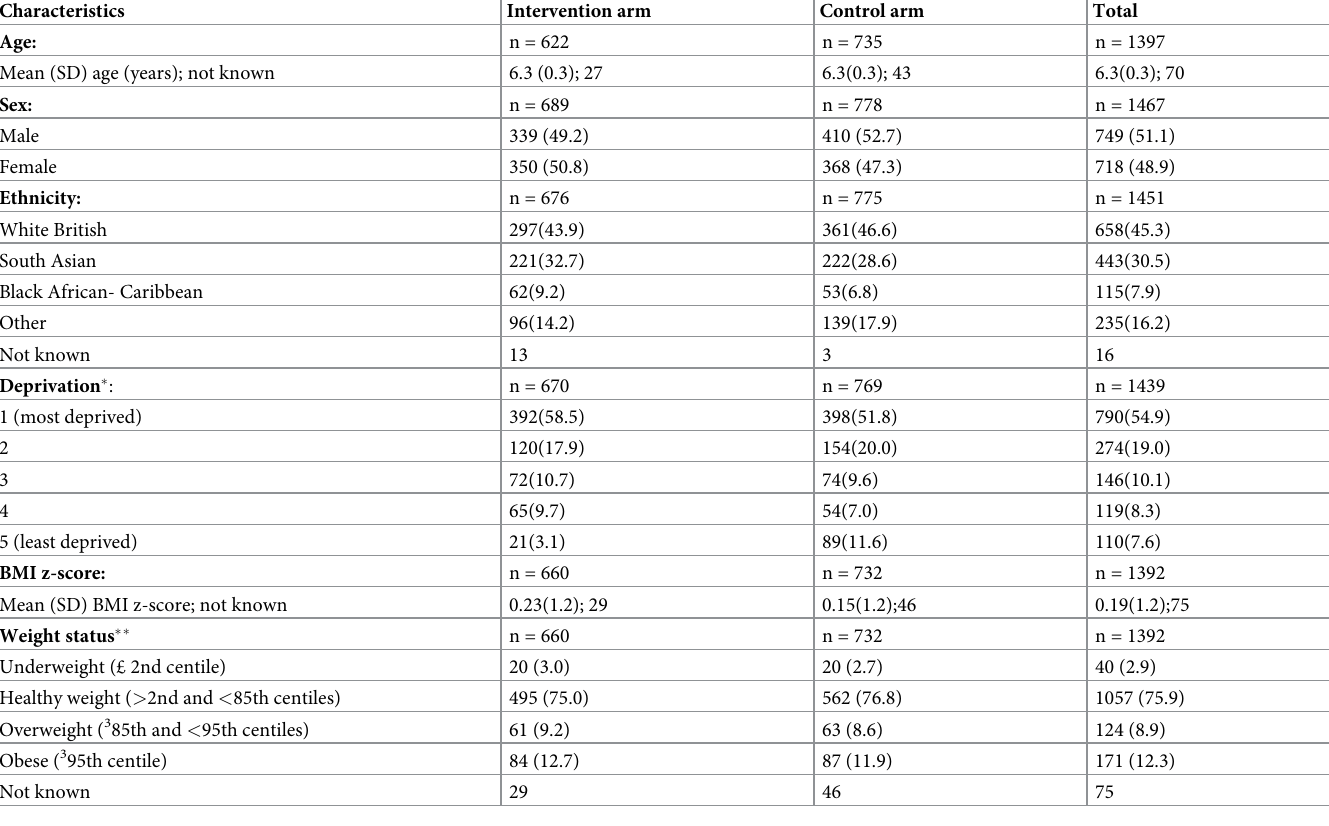
Table 1. Baseline characteristics of pupils in the WAVES study by trial arm. Characteristics Intervention arm Control